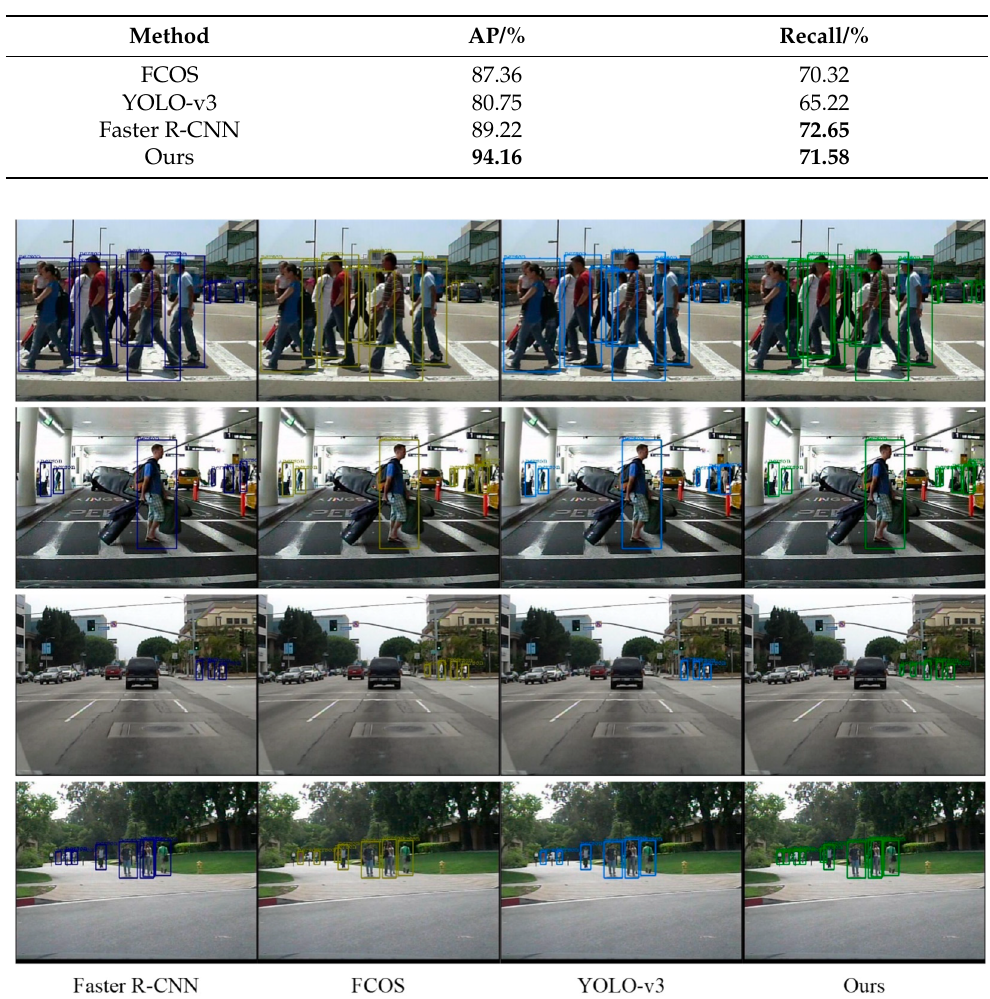
Figure 11. Comparison of our method results with other methods on the Caltech pedestrian